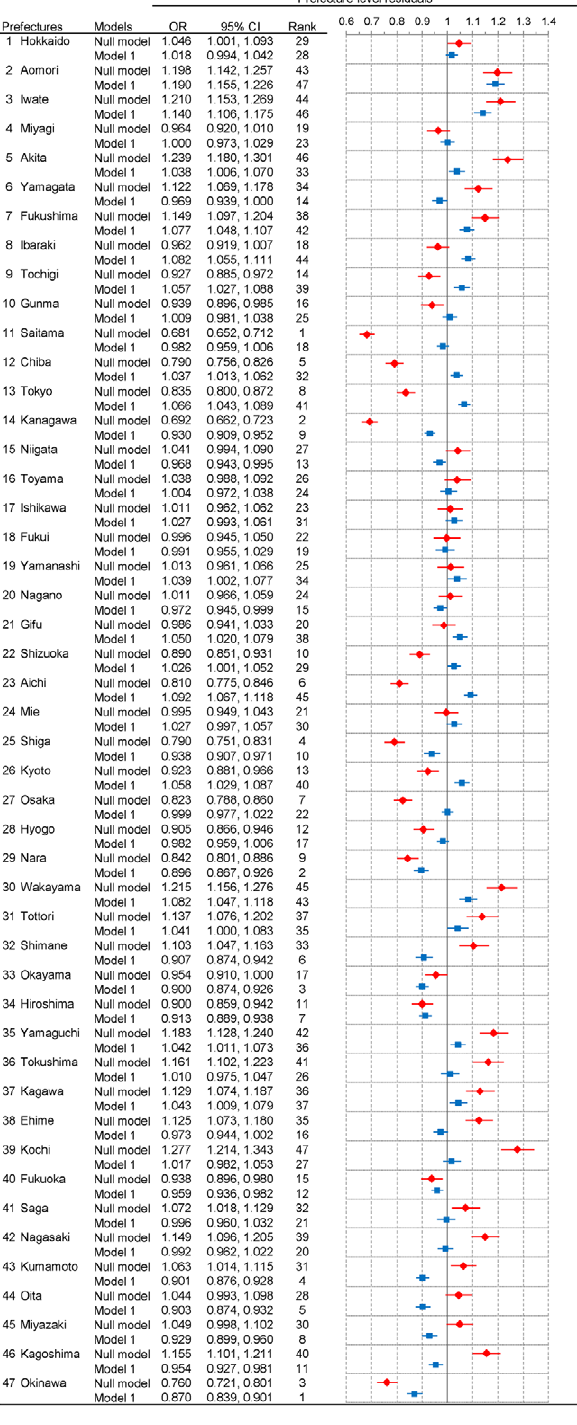
Figure 2. Unadjusted and adjusted prefecture-level residuals for all-cause mortality among men in 47 prefectures, Japan, 2005. Prefecture-level residuals are described in odds ratios with the reference being the grand mean of all prefectures. Red diamond and blue square represent point estimates of residuals from null model and model 1, respectively. Horizontal bars represent their 95% credible intervals. Prefectures with a lower estimate of odds for all-cause mortality are ranked higher. Note that CI and OR stand for credible interval and odds ratio, respectively.